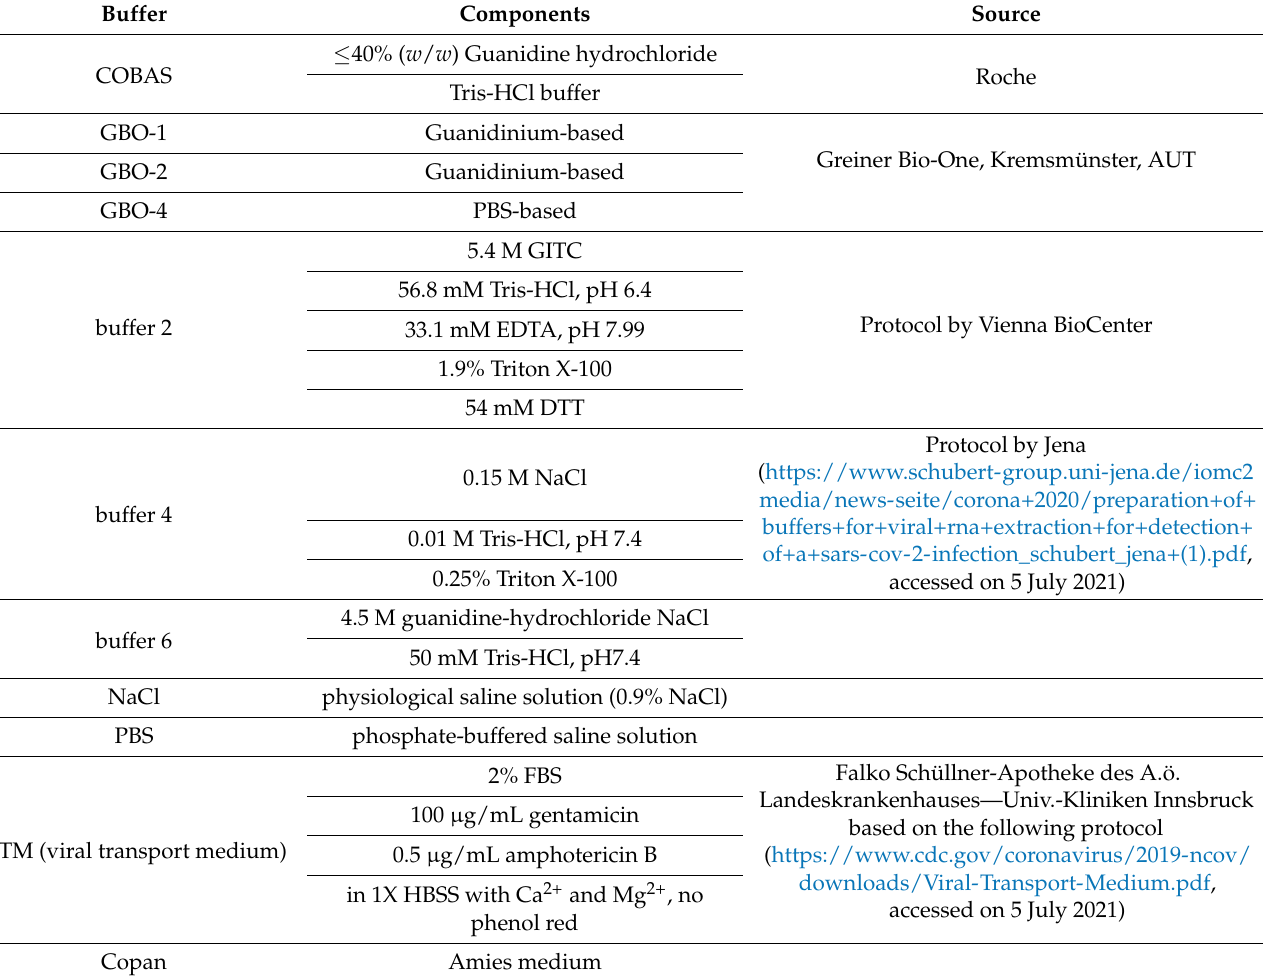
Table 1. Chemical composition of different buffers used in this study.